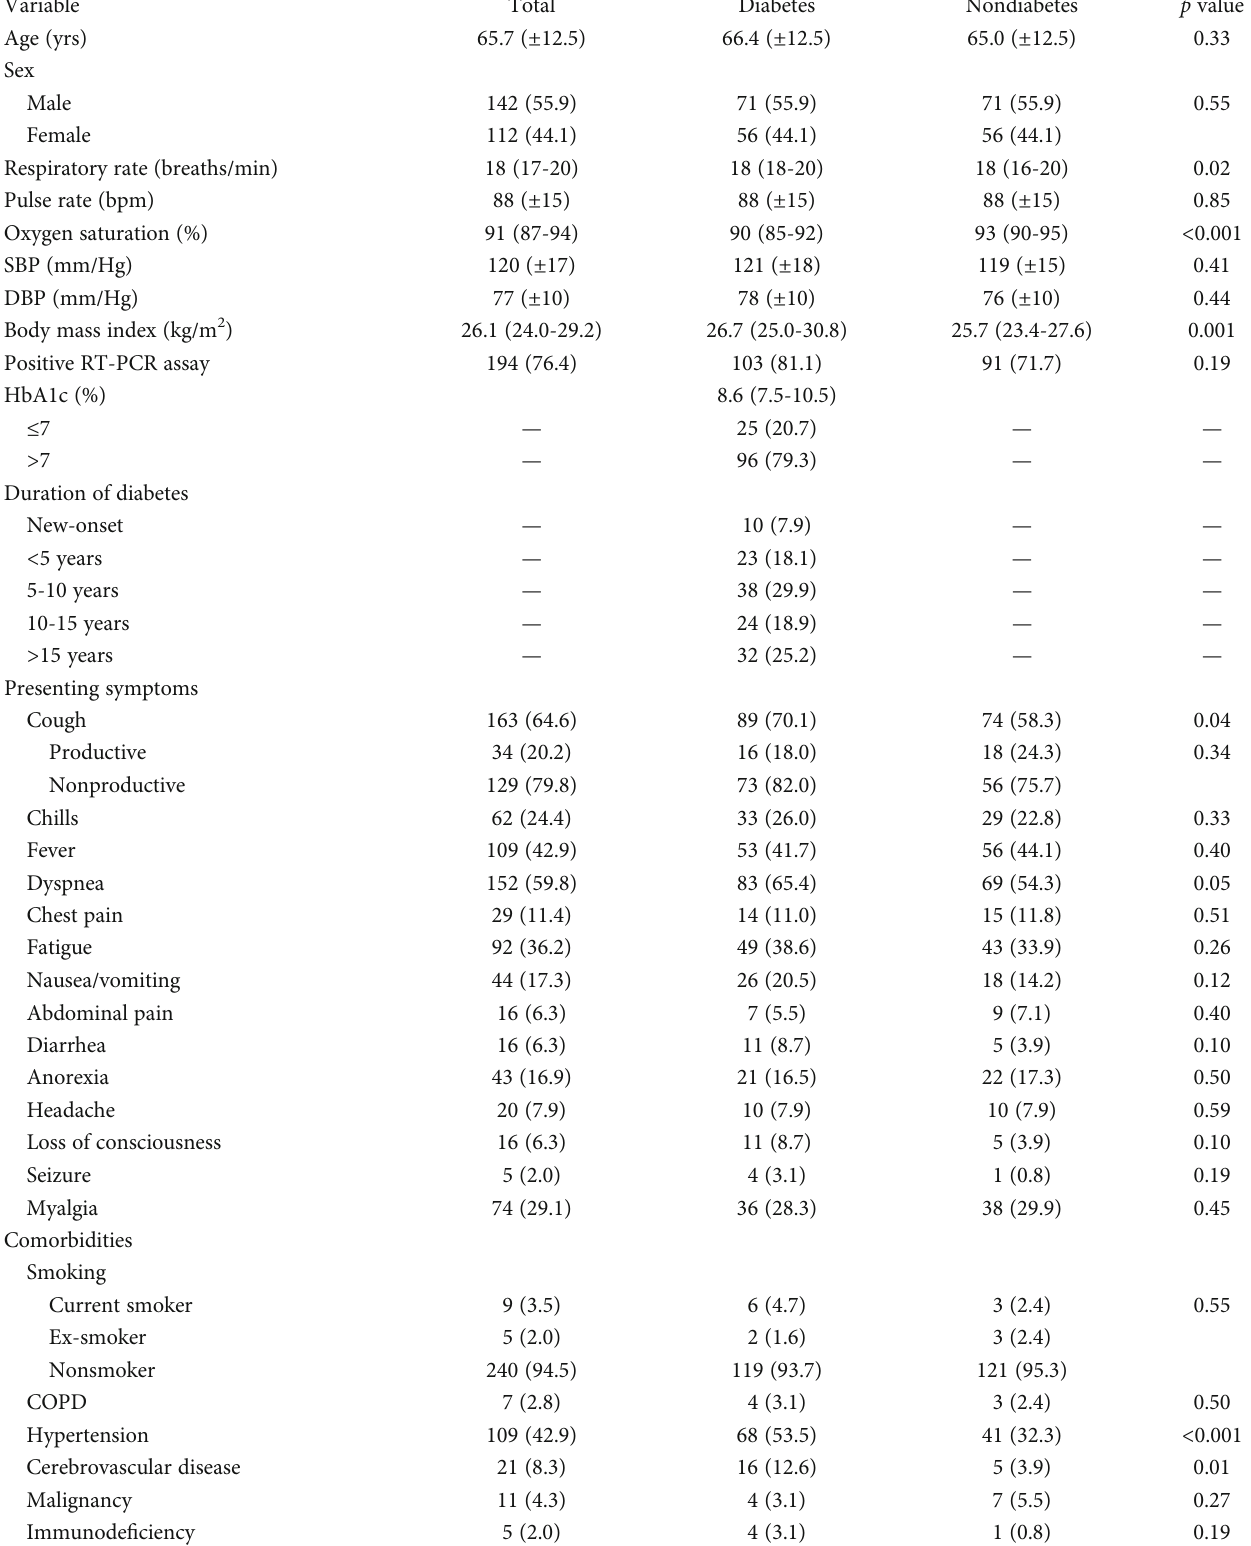
Table 1: Baseline characteristics of patients with COVID-19, by diabetes